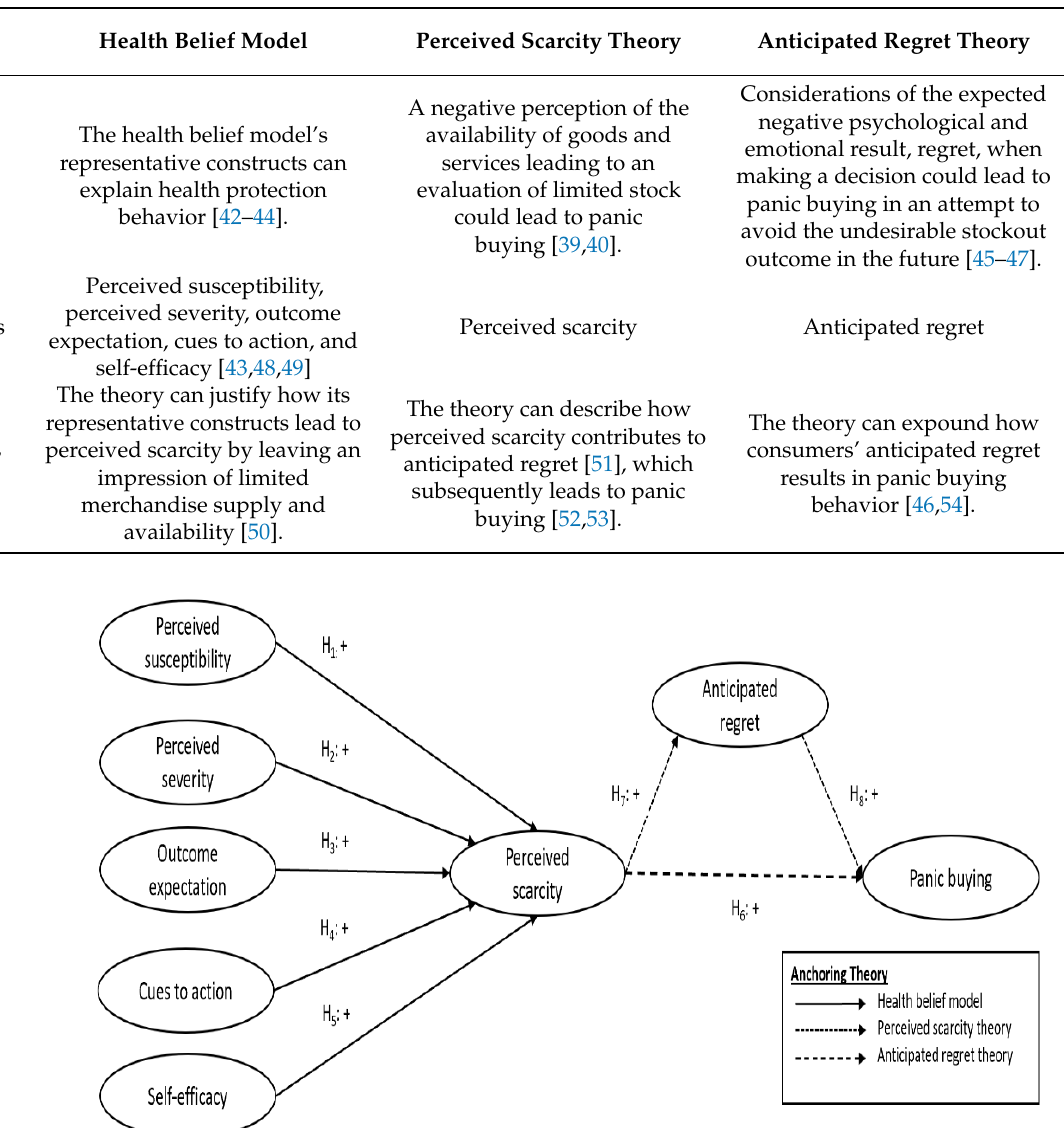
Table 1. A review of belief theories and factors affecting panic buying behavior.